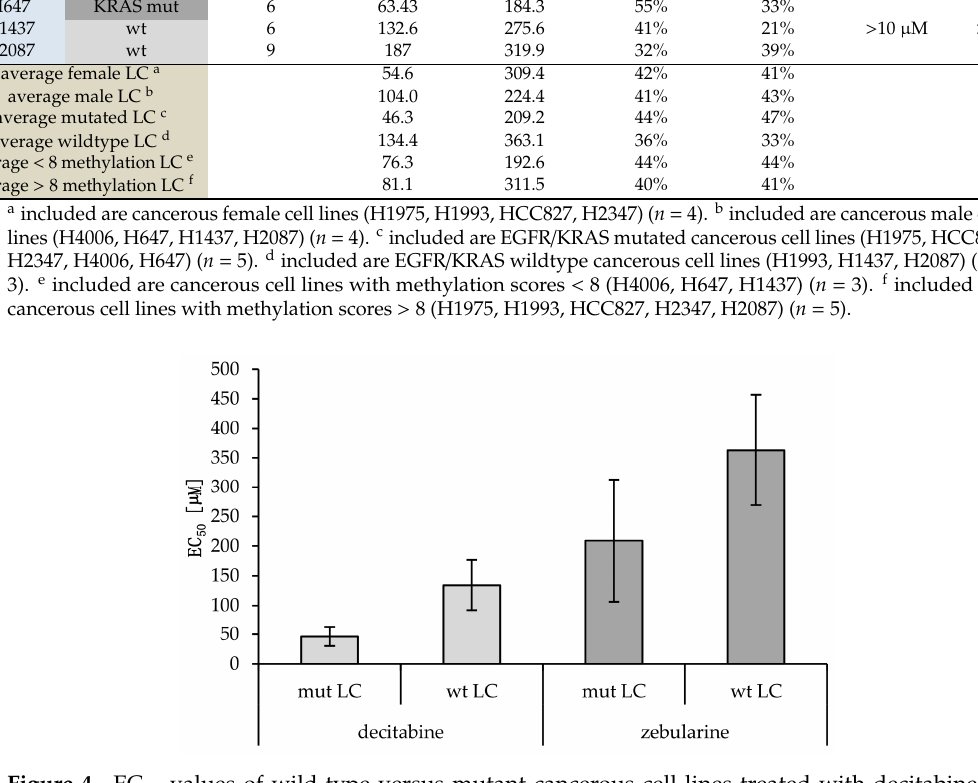
Figure 4. EC 50 values of wild-type versus mutant cancerous cell lines treated with decitabine or zebularine. Averages and standard deviations are shown (n mut LC = 5; n wt LC = 3). A statistically significant difference between the decitabine EC 50 values of mut versus wt cell lines was found ( p = 0.01, Student’s t-test). No statistical significance was reached for zebularine ( p = 0.12; Students t-test).